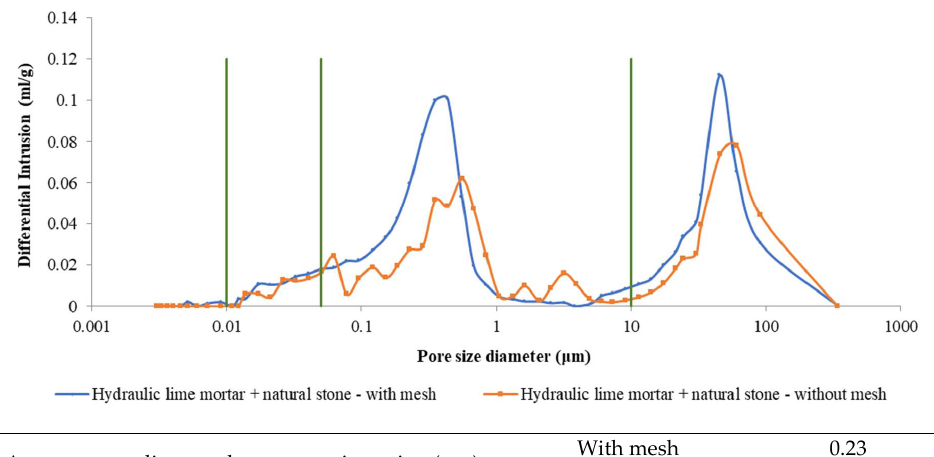
Figure 11. Porosimetry properties obtained by mercury intrusion of hydraulic lime mortar applied to solid ceramic brick substrate, with and without mesh. Table 10. Hydraulic lime mortar applied to the natural stone substrate.